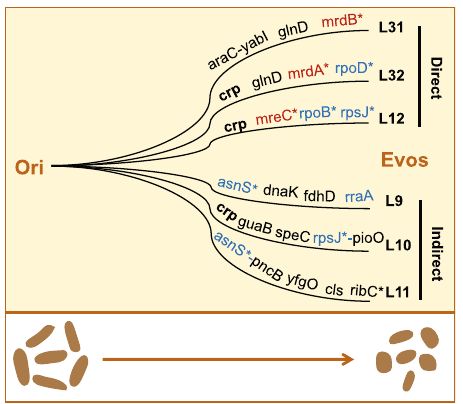
Fig. 7 Differentiated genetic strategies. Genome mutations detected in the six Evos are indicated. The essential genes are indicated with asterisks. The genes that played a role in the cellular structure and the cellular protein abundance are highlighted in red and blue, respectively. The mutated gene that appeared in multiple lineages is in bold. The cell shapes of the original and evolved E. coli cells are illustrated at the